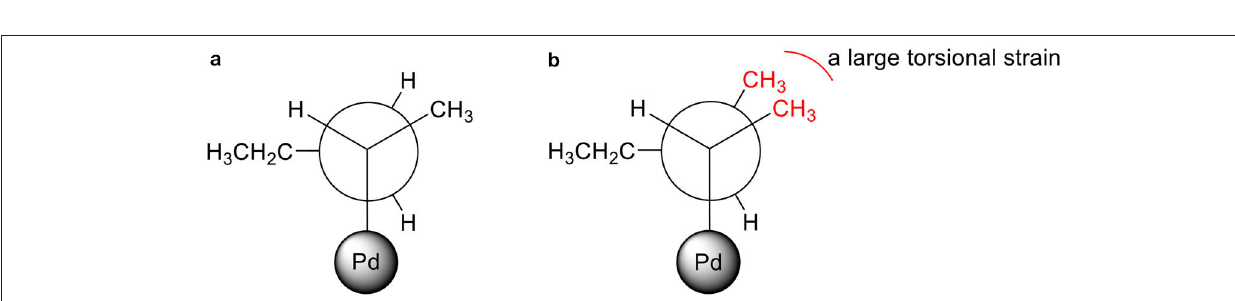
FIGURE 3 | Newman projections of branched mono- σ bonded Pd-alkyl intermediates in totally eclipsed confirmations: (a) pent-1-ene and (b)